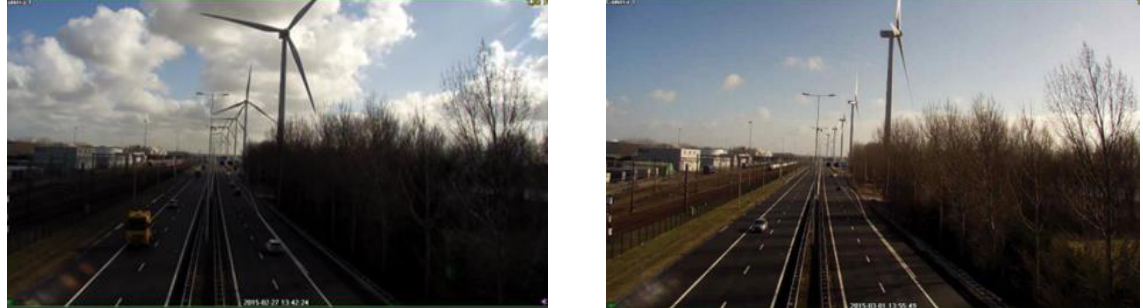
Figure 3. View of the project site with wind turbines in perpendicular condition (left) and parallel condition